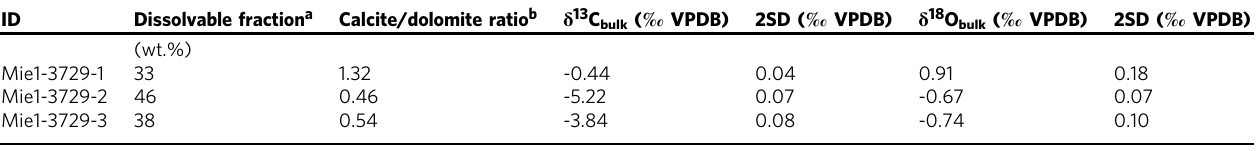
a dissolved by 2.25 N HNO3 b XRD